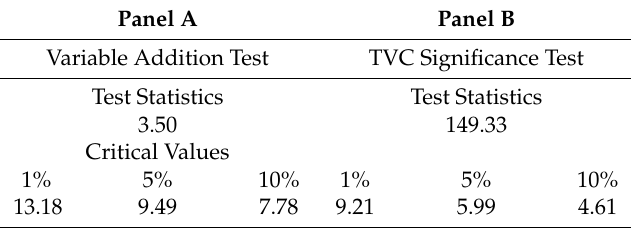
Table 3. Cointegration and TVC Significance tests results.